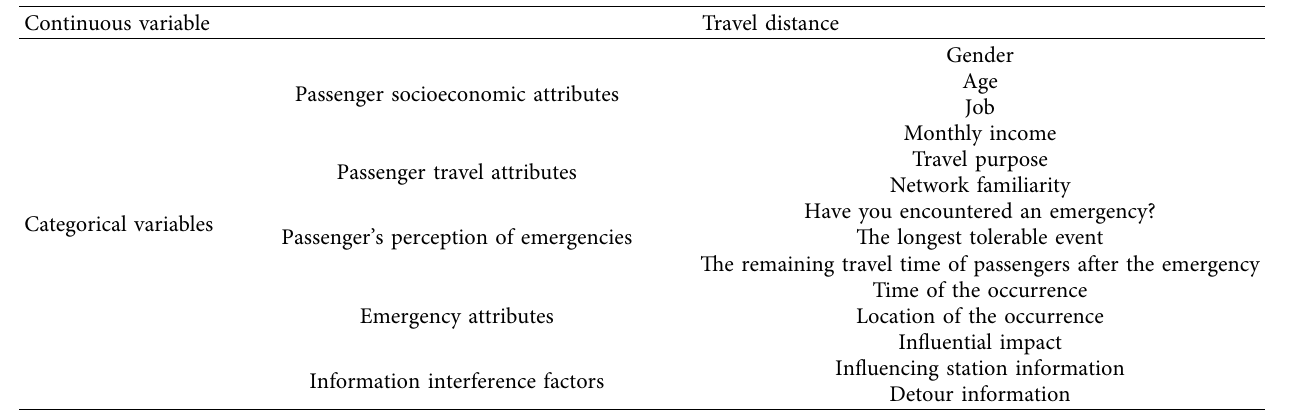
Table 4: Description of independent